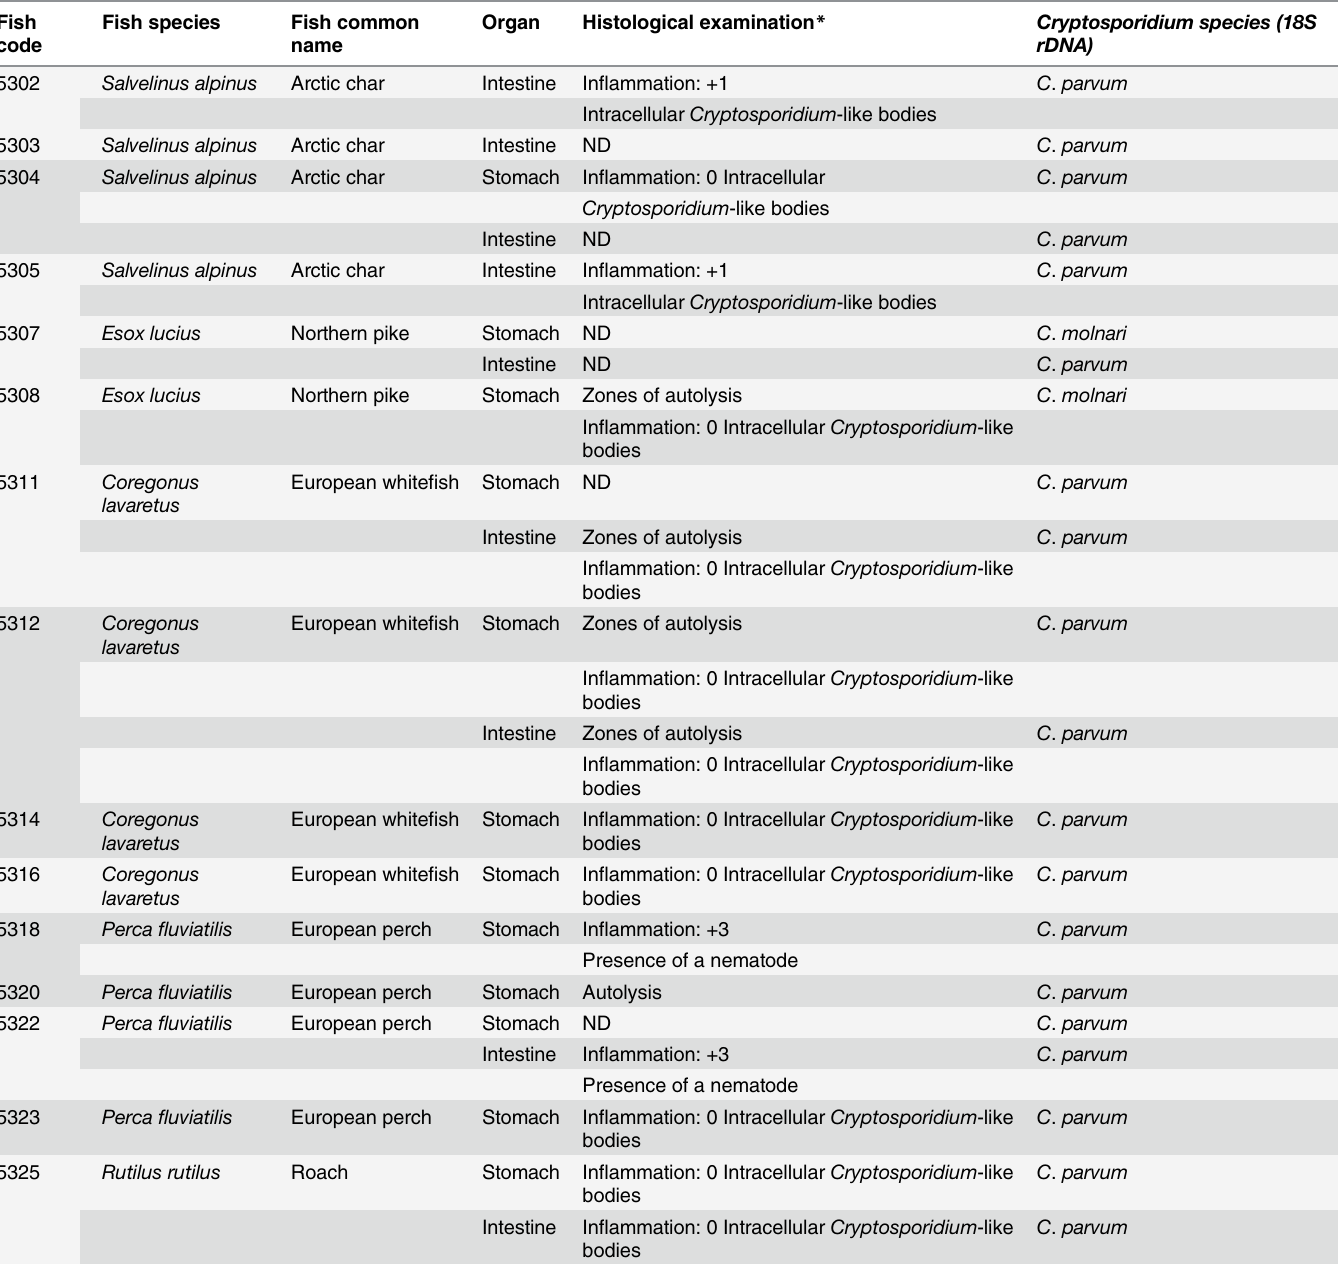
Table 3. Histological examination of digestive organs of different fish species from Lake Geneva infected by Cryptosporidium spp. Fish